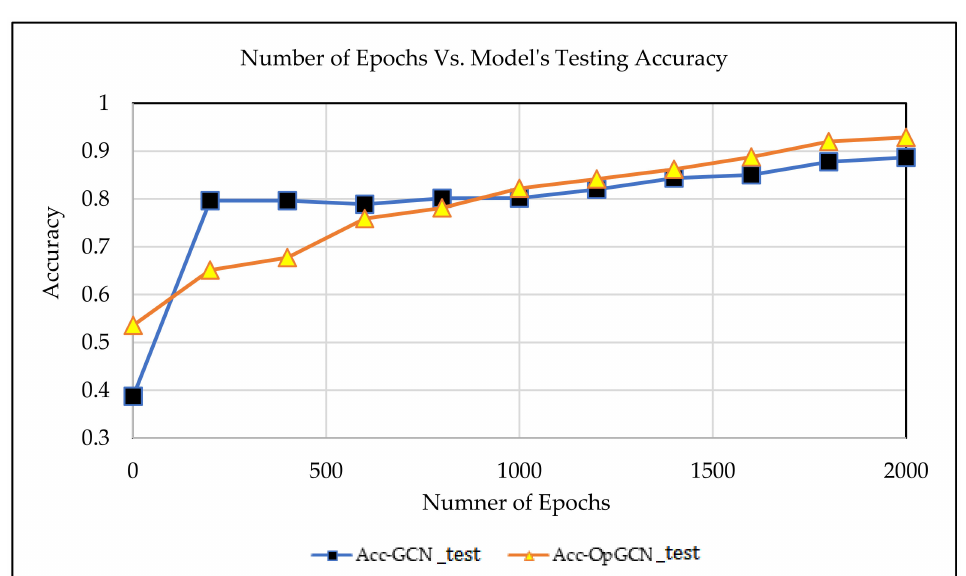
Figure 9. Epochs vs. training accuracy.